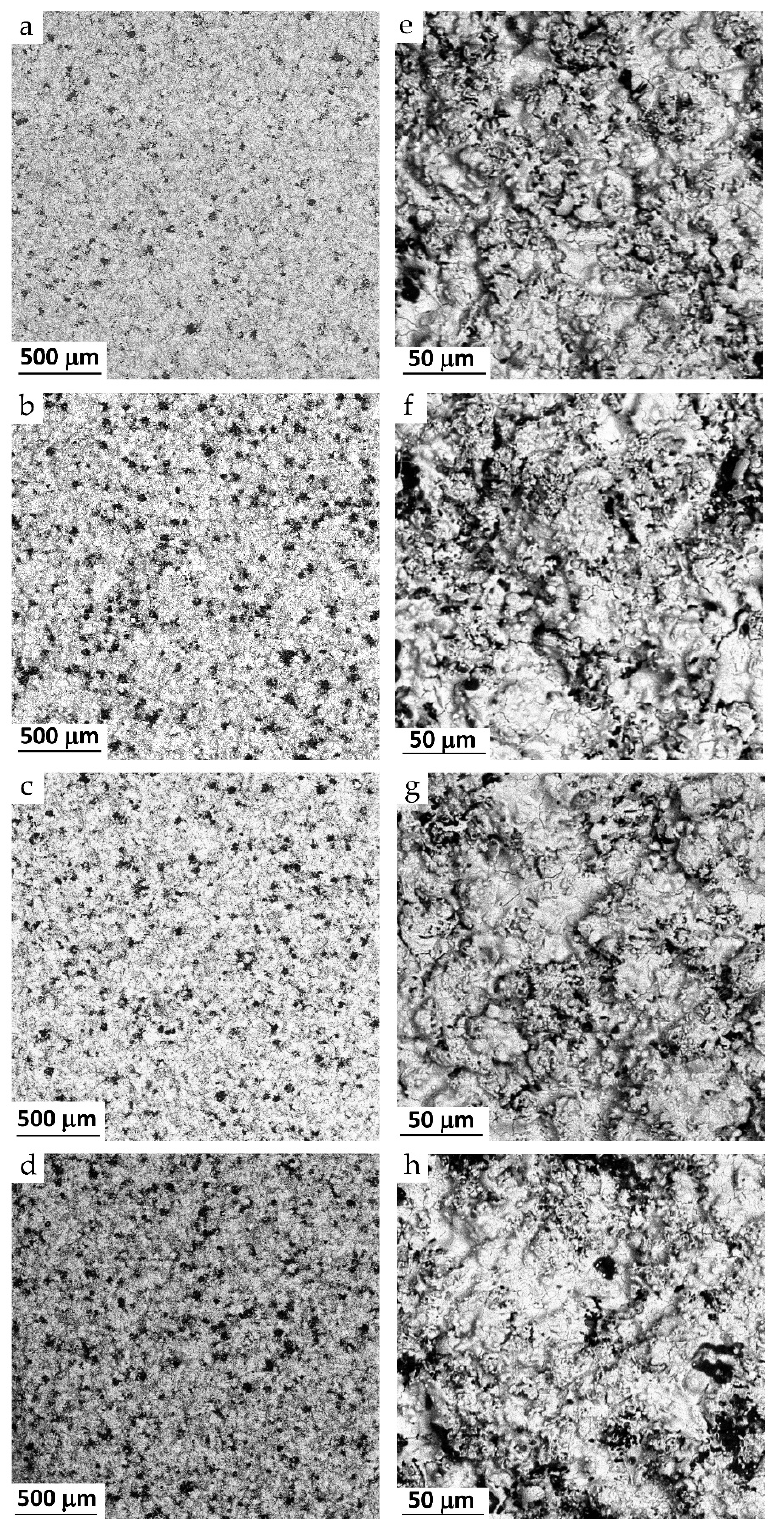
Figure 4. Morphological aspects of coated samples: ( a ) S1-ZrO 2 ; ( b ) S2-ZrO 2 ; ( c ) S3-ZrO 2 ; ( d ) S4-ZrO 2 ; ( e ) S1-ZrO 2 ; ( f ) S2-ZrO 2 ; ( g ) S3-ZrO 2 ; ( h ) S4-ZrO 2 .